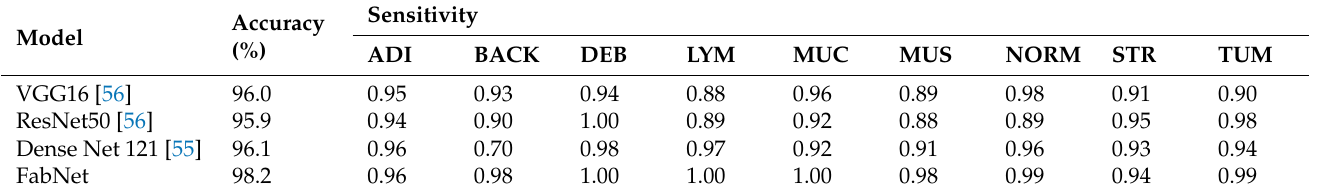
Table 7. Detailed classification results by FabNet on NCT-CRC-HE-100K dataset concerning bench- mark models in terms of accuracy and sensitivity.